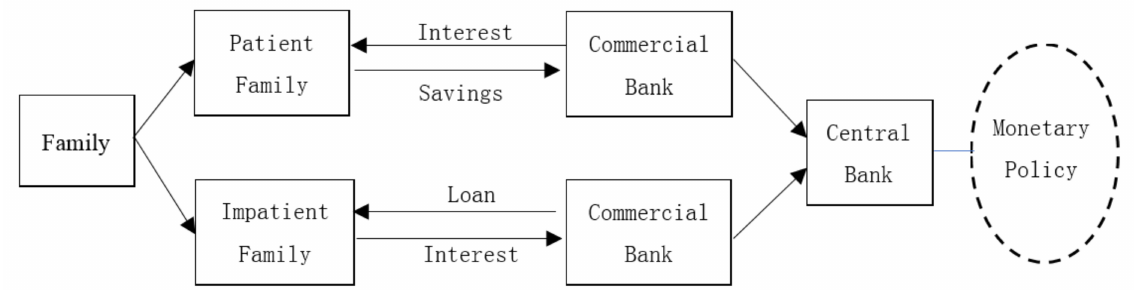
Figure 1. The relationship between the behavior of monetary